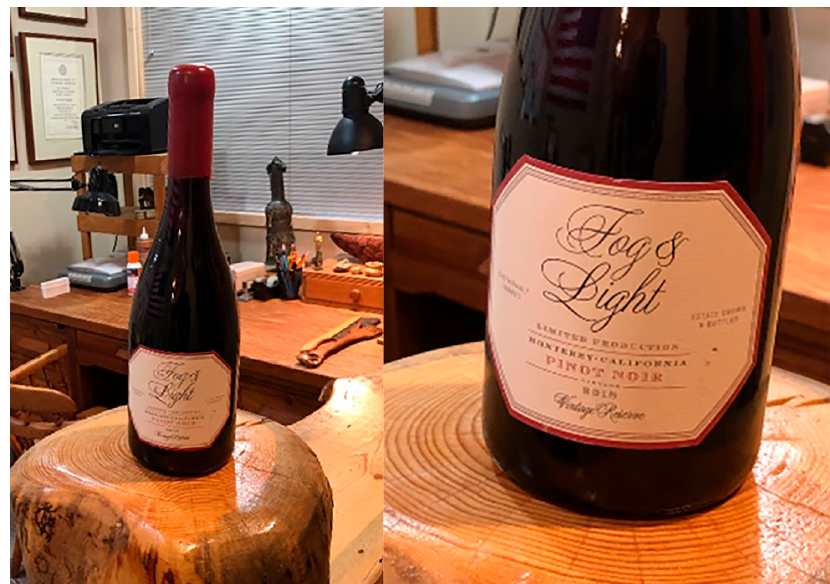
Figure 4. The image on the left is a bottle with a wax seal on the cork and a closeup of the label with the name Fog and Light. The wax seal conveys extra care for a better wine and the poetic name Fog & Light conveys deep meaning, much like the flavors of good wine (Photos by